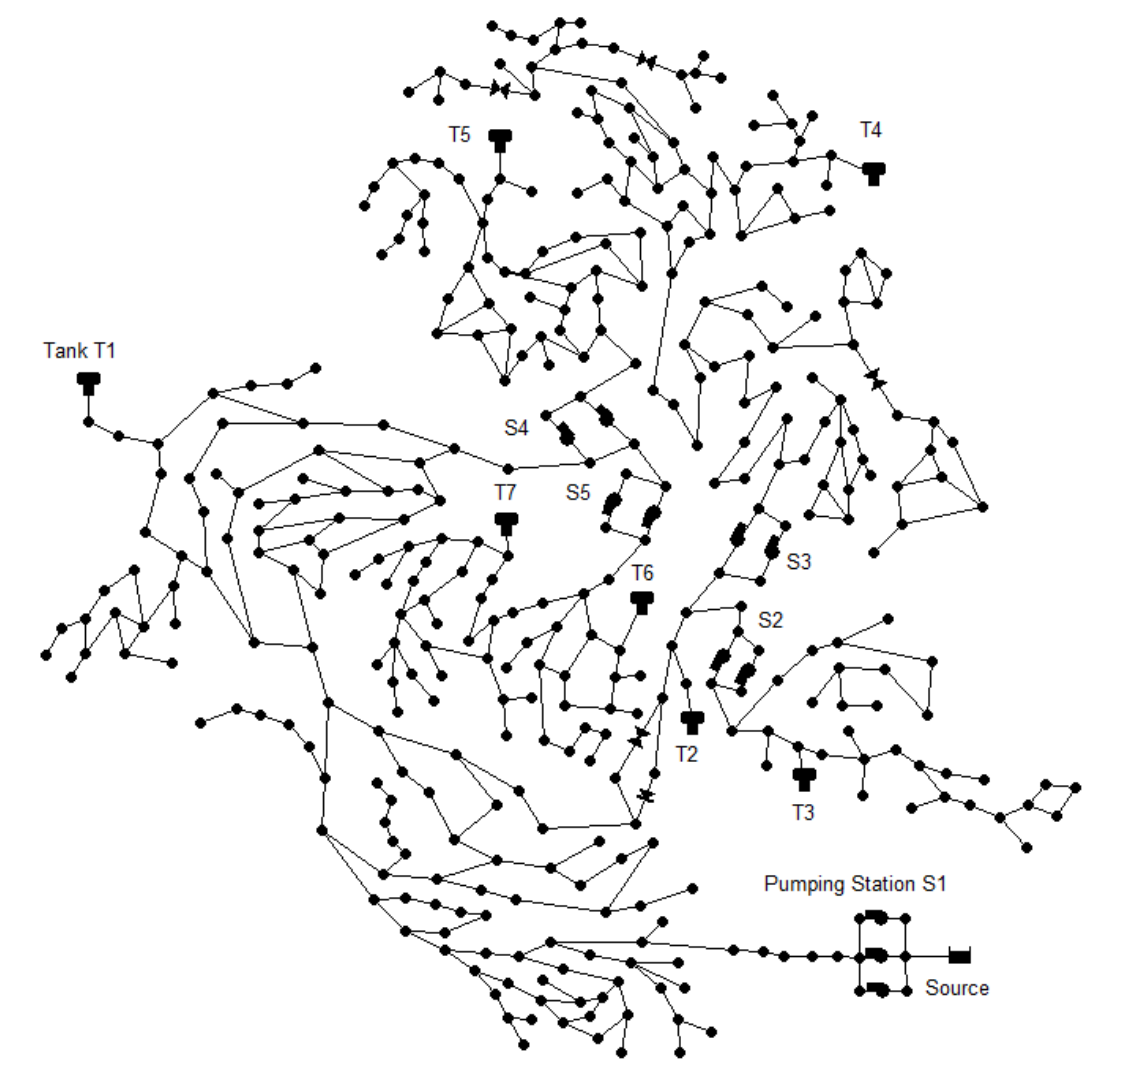
Figure 2. Test problem considered (the C-Town network). S1–S5 denotes the five pumping stations, and T1–T7 denotes the seven tanks.